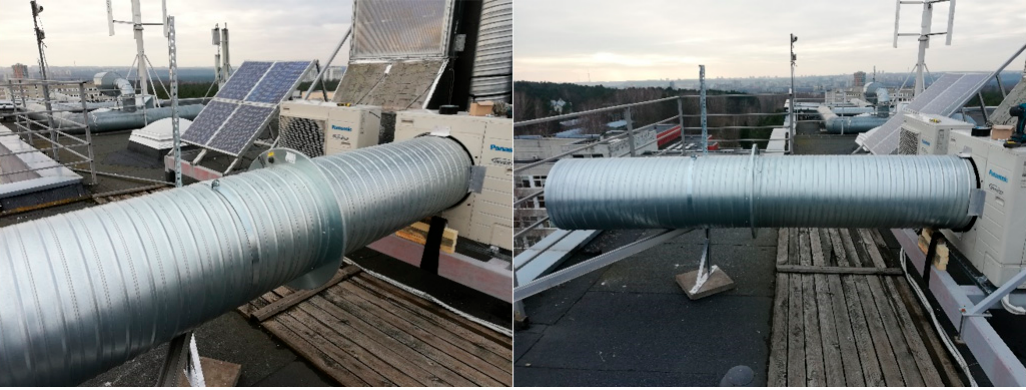
Figure 2. The experimental setup on the roof of VILNIUS TECH.